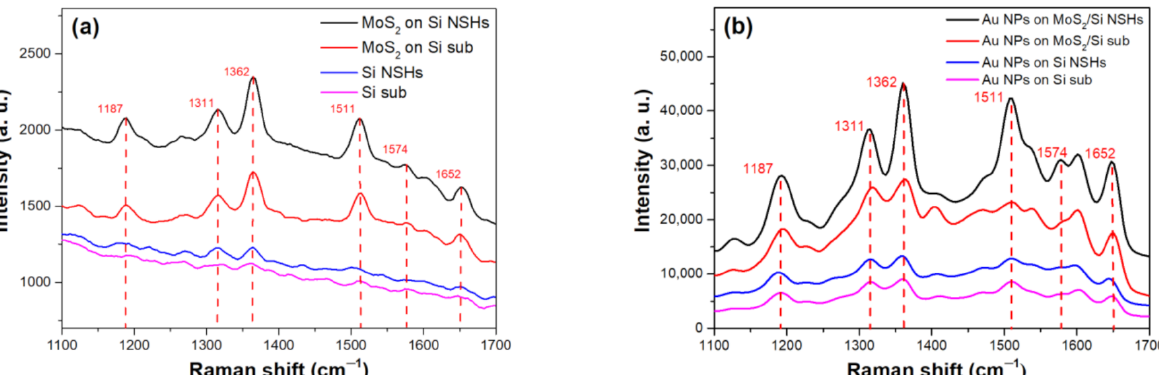
Figure 4. ( a ) Before and ( b ) after spreading Au NPs, SERS signals of R6G molecules (10 –6 M) on planar Si, Si NSHs, few-layer MoS 2 /Si, and few-layer MoS 2 /Si NSHs